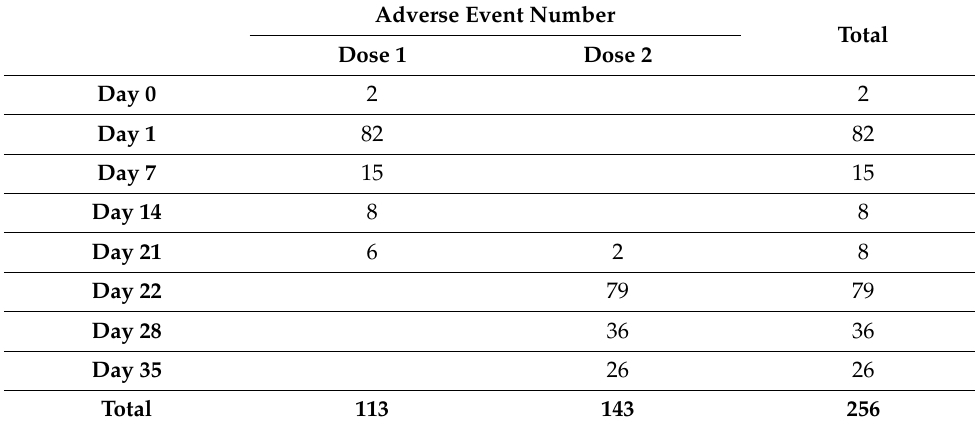
Table 3. Incidence rate of adverse events at each time point after vaccination.